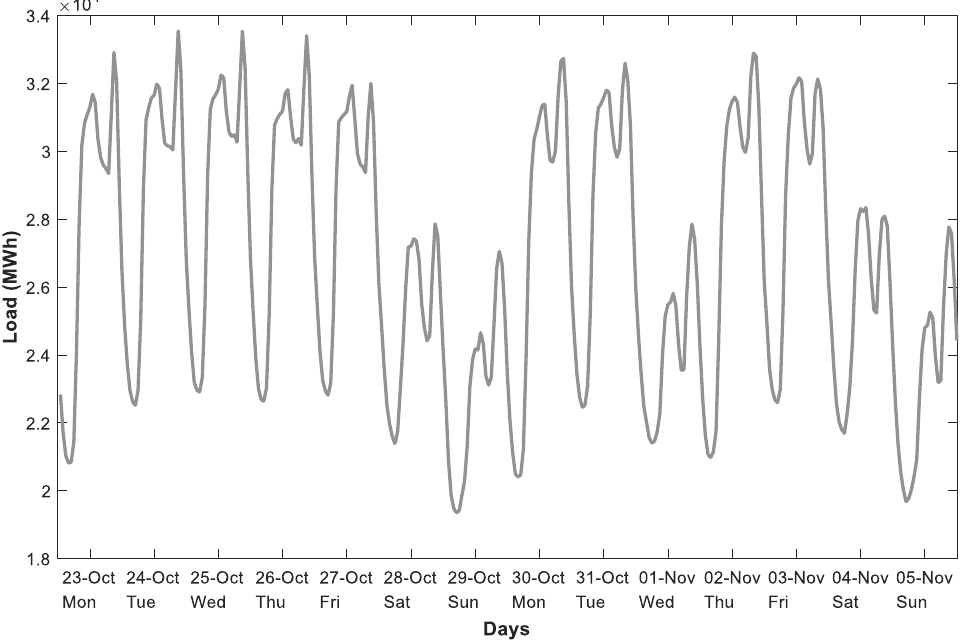
Figure 1. Hourly electricity demand in Spain from 23 October 2017 to 5 November 2017.